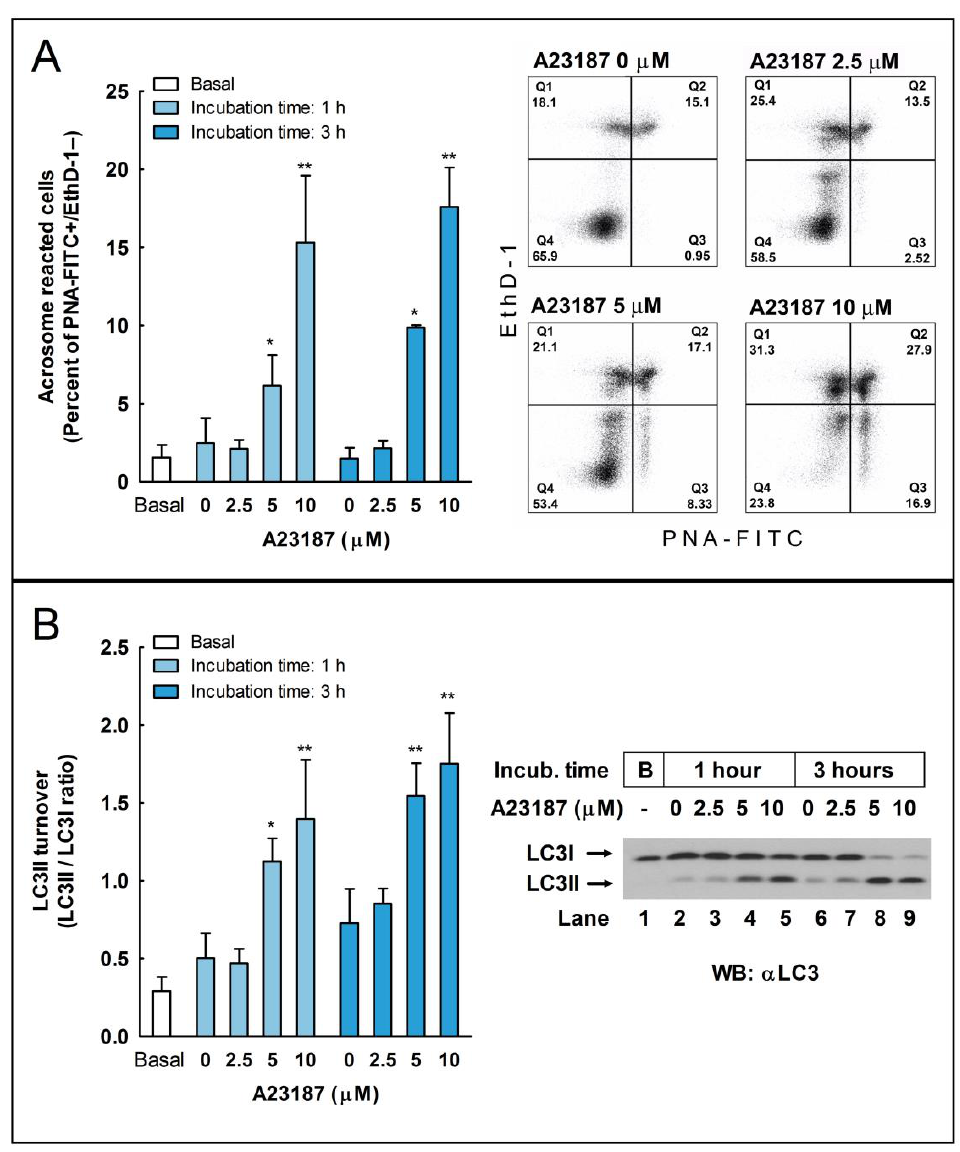
Figure 2. The induction of the acrosome reaction and enhanced LC3II processing by the calcium ionophore A23187 in stallion spermatozoa. ( A ) Ejaculated equine spermatozoa were immediately processed (basal) or preincubated for 30 or 150 min in BWW at 37 °C and then were challenged with the indicated concentrations of A23187 (2.5, 5, and 10 µM) or vehicle (0 µM; DMSO) for 30 additional min in the same incubation vial (the final incubation time in capacitating conditions were, respectively, 1 and 3 h). After incubation, spermatozoa were washed with PBS and labeled with probes to characterize by flow cytometry the DNA content (Hoechst 33342), sperm viability (Ethidium Ho- modimer-1; EthD-1), and acrosome status (Lectin from Arachis hypogaea FITC-conjugated; PNA- FITC). To select the sperm population, cytometer events were gated according to DNA content (Hoechst 33342+ events) and then were classified in four quadrants corresponding with the detec- tion or not of each of the remaining fluorophores, resulting in dead unreacted cells (EthD-1+ and PNA- FITC‒; Q1), dead reacted cells (EthD -1+ and PNA-FITC+; Q2), live reacted cells (EthD- 1‒ and PNA-FITC+; Q3), and live unreacted cells (EthD- 1‒ and PNA - FITC‒; Q4). Results in the graph rep- resent the mean ± SEM of six independent experiments expressed as a percentage of acrosome re- acted live sperm cells (Q3 quadrant). Bars with an asterisk indicate significant differences compared to the control (vehicle) by a two- tailed Student’s t -test for unpaired samples (* p < 0.05; ** p < 0.01). In the right of the panel, representative density plots obtained are displayed of when stallion